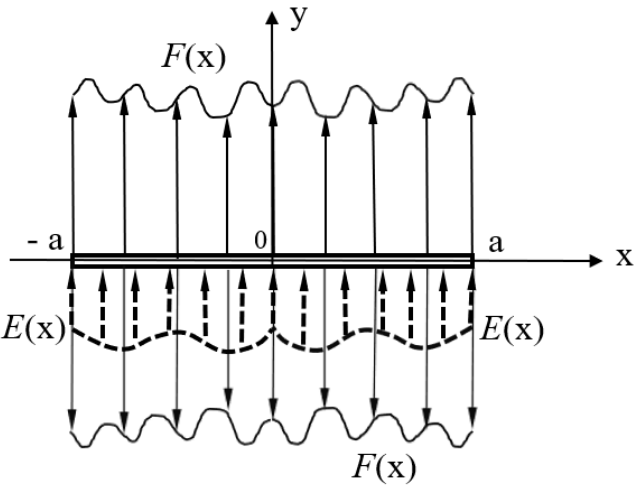
Figure 1. A single crack under symmetrical heat flow E ( x ) and symmetrical mechanical loading F ( x ).